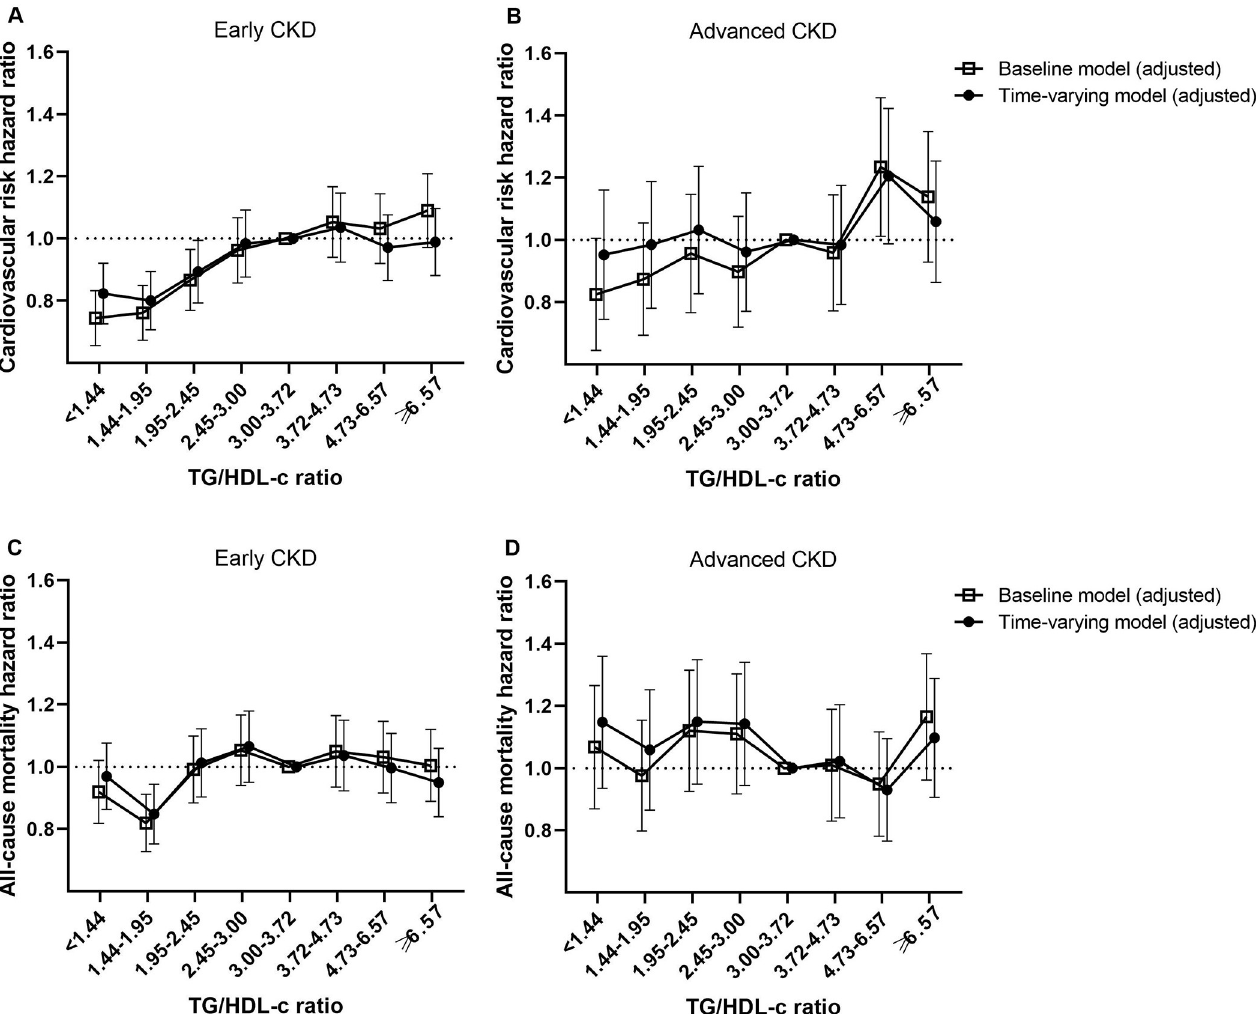
Fig 3. Multivariate-adjusted MACE (A and B) and all-cause mortality (C and D) hazard ratios by serum TG/HDL-c ratio in early CKD and advanced CKD